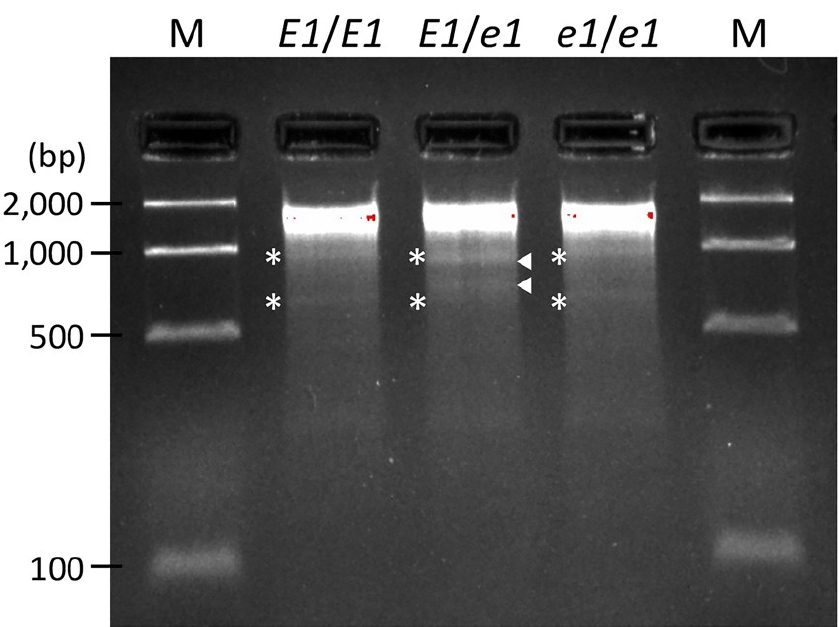
Figure 5. Mismatch-based mutant gene detection using CEL I nuclease; PCRs including the muta- tion in the E1 gene were performed using template DNA from wild type Hiden ( E1 / E1 ), a mixed heterozygous-mimic sample using DNA from Hiden and the 17-0040 mutant ( E1 / e1 ) and DNA from the 17-0040 mutant ( e1 / e1 ). After hetero-duplex formation through heat−denature/annealing cycles, samples were treated with the mismatch-specific nuclease CEL I. White arrowheads indicate CEL I-digested E1 fragments. Asterisks indicate nonspecific PCR fragments.